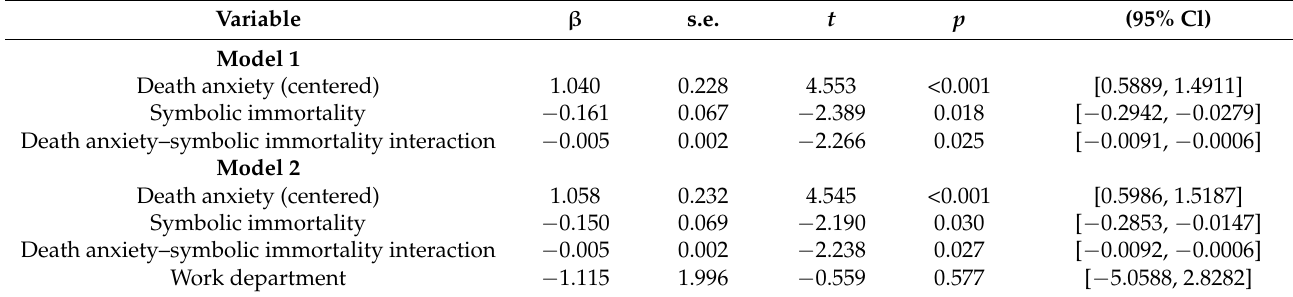
Table 3. Predictor and interaction statistics ( n =